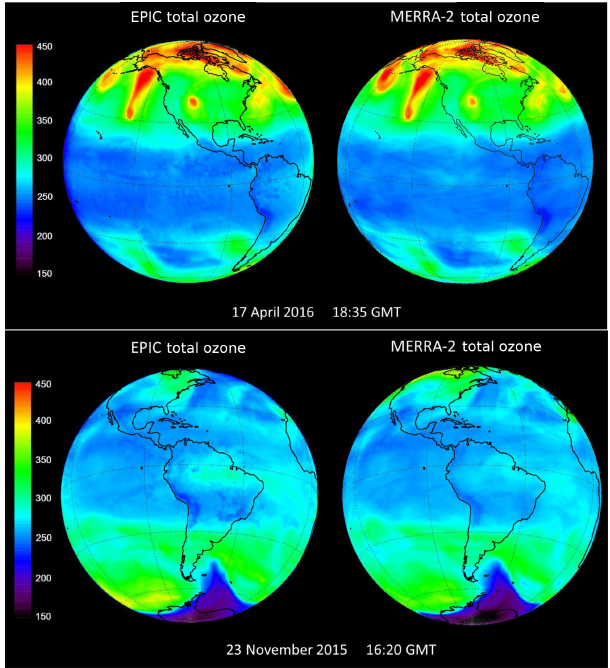
Figure 9. Comparison of EPIC total column ozone with the MERRA-2 assimilation model ozone.